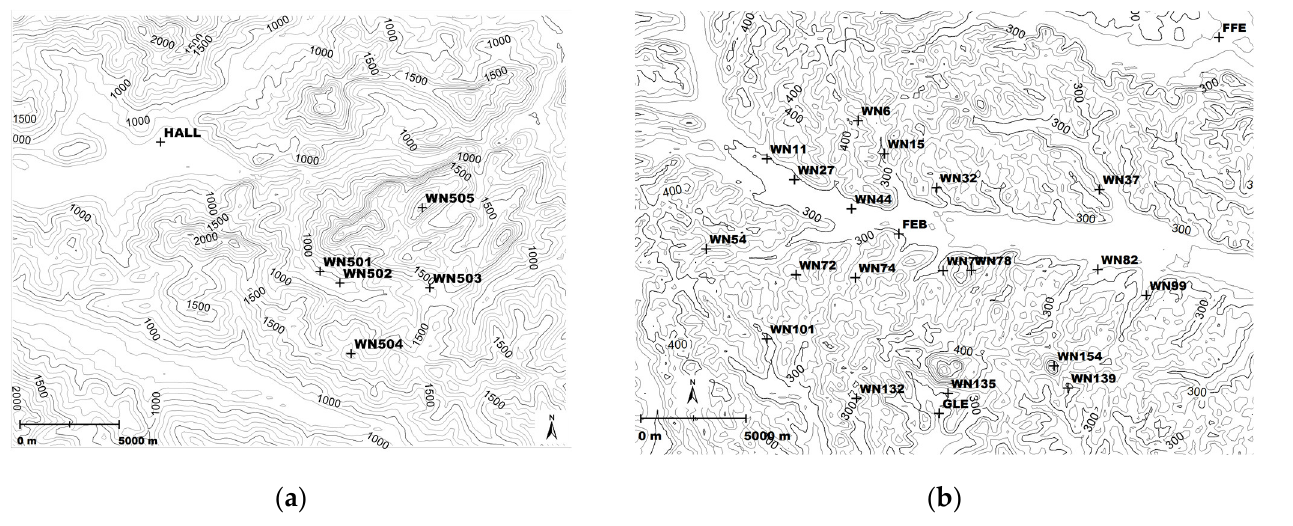
Figure 2. Weather map issued by the Austrian Meteorological Service ZAMG for the 13 October 2017 for 6 UTC [23]. H = high pressure; T = low pressure; HTK = upper-level low.